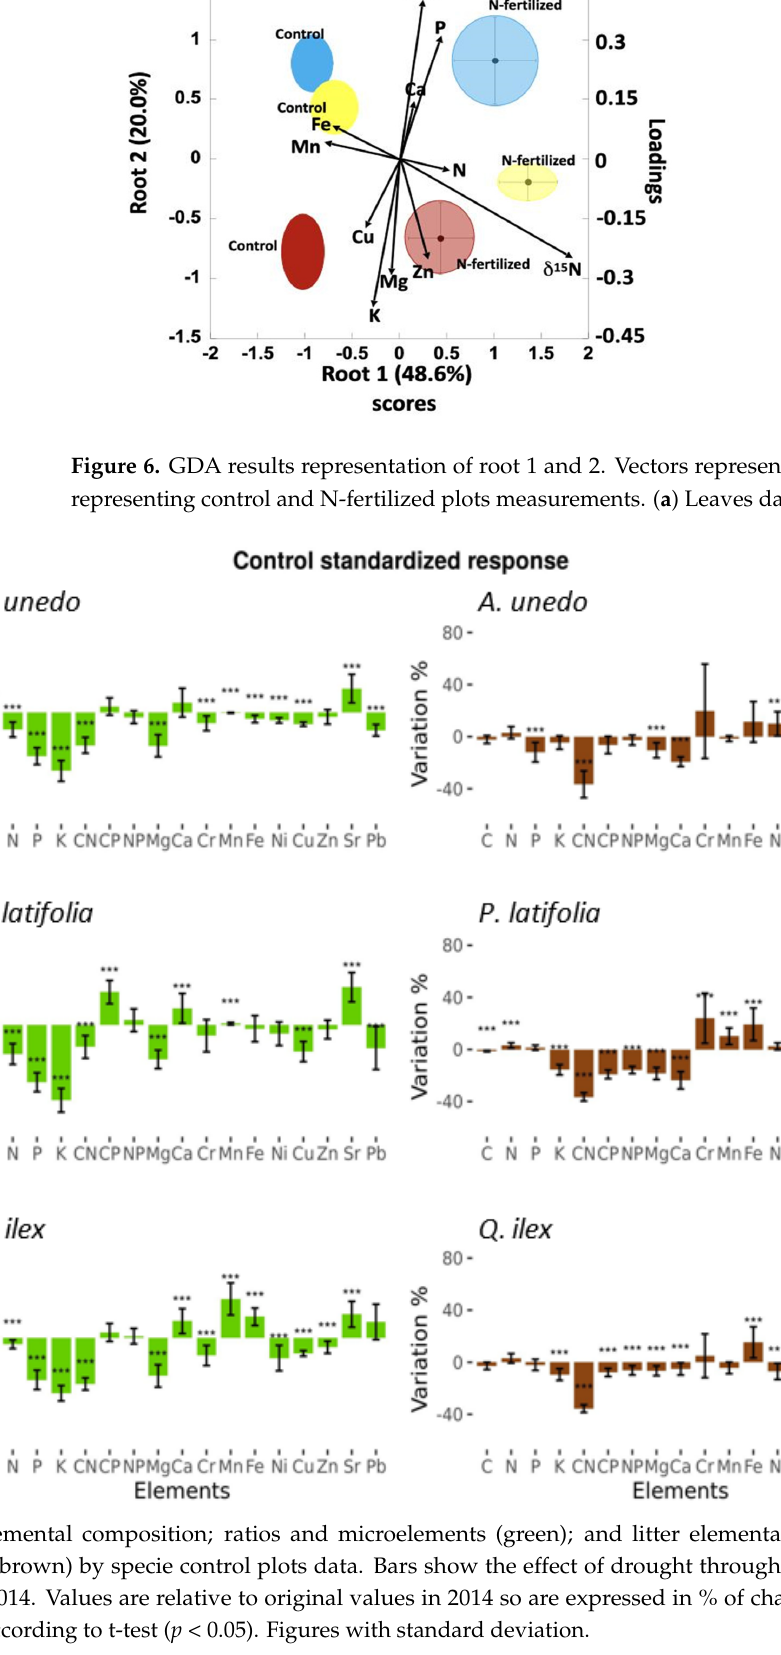
Figure 7. Foliar elemental composition; ratios and microelements (green); and litter elemental composition, ratios, and microelements (brown) by specie control plots data. Bars show the effect of drought through the values difference between 2015 and 2014. Values are relative to original values in 2014 so are expressed in % of change. *** = Significant differences from 0 according to t-test ( p < 0.05). Figures with standard deviation. In foliar litter elemental composition, the differences between 2014 and 2015 likely due to drought vary more between species than in foliar elemental composition. A. unedo has significant decreases in P, C:N, Mg, Ca, Zn, and Sr, and significant increase in Ni. P. latifolia has significant increases in N, Cr, Mn, Fe, and Pb, and significant decreases in C, K, C:N, C:P, N:P, Mg, Ca, Cu, Zn and Sr. In Q. ilex , there is a significant increase only in Fe and significant decreases in K, C:N, C:P, N:P, Mg, Ca, Ni, and Zn (Figure 7).